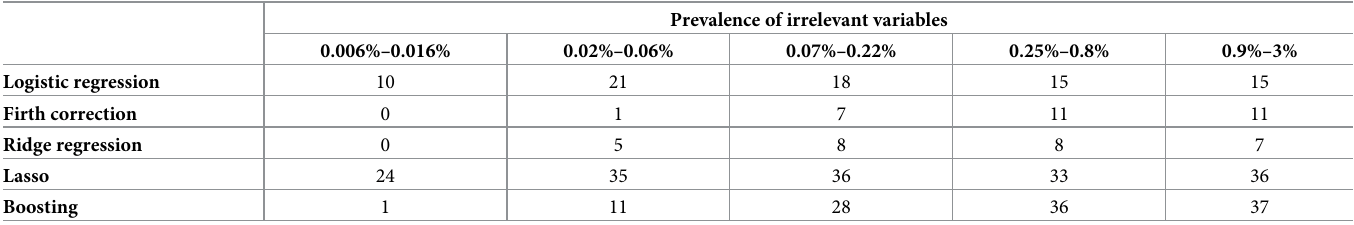
Table 2. CESIR simulation: Selection rates (%) for the 45 irrelevant variables, grouped together by prevalence (9 variables per